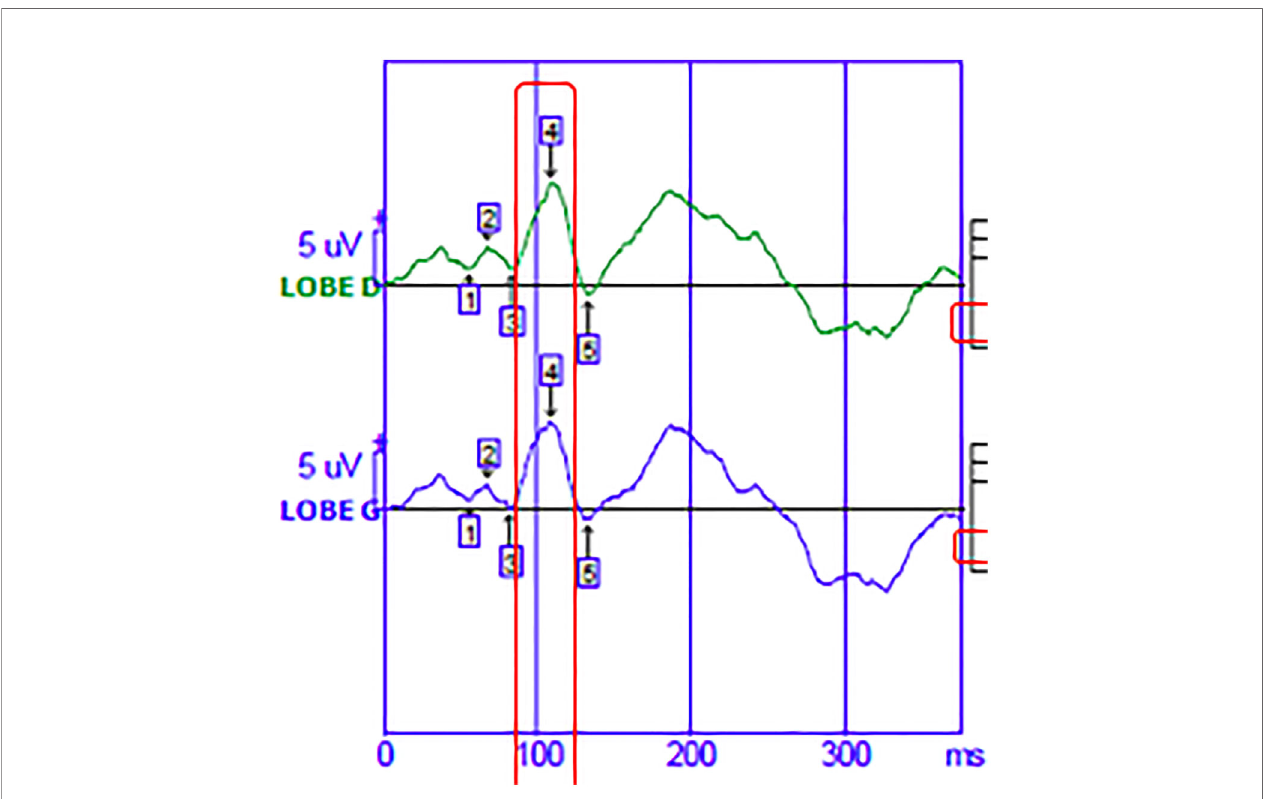
FIGURE 1 | Visual evoked potential.The green curve corresponds to the nerve signal born in the visual cortex of the right occipital lobe. The blue curve corresponds to the nerve signal born in the visual cortex of the left occipital lobe.The abscissa shows the time in milliseconds. On the ordinate is the amplitude of the wave in